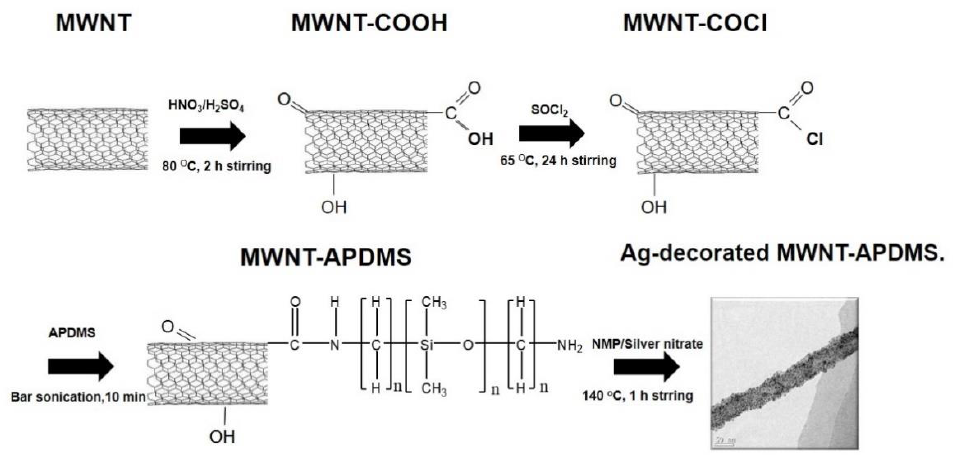
Figure 1. Schematic procedure for the preparation of multi-walled carbon nanotubes-amine-terminated poly(dimethylsiloxane) (MWNT-APDMS).